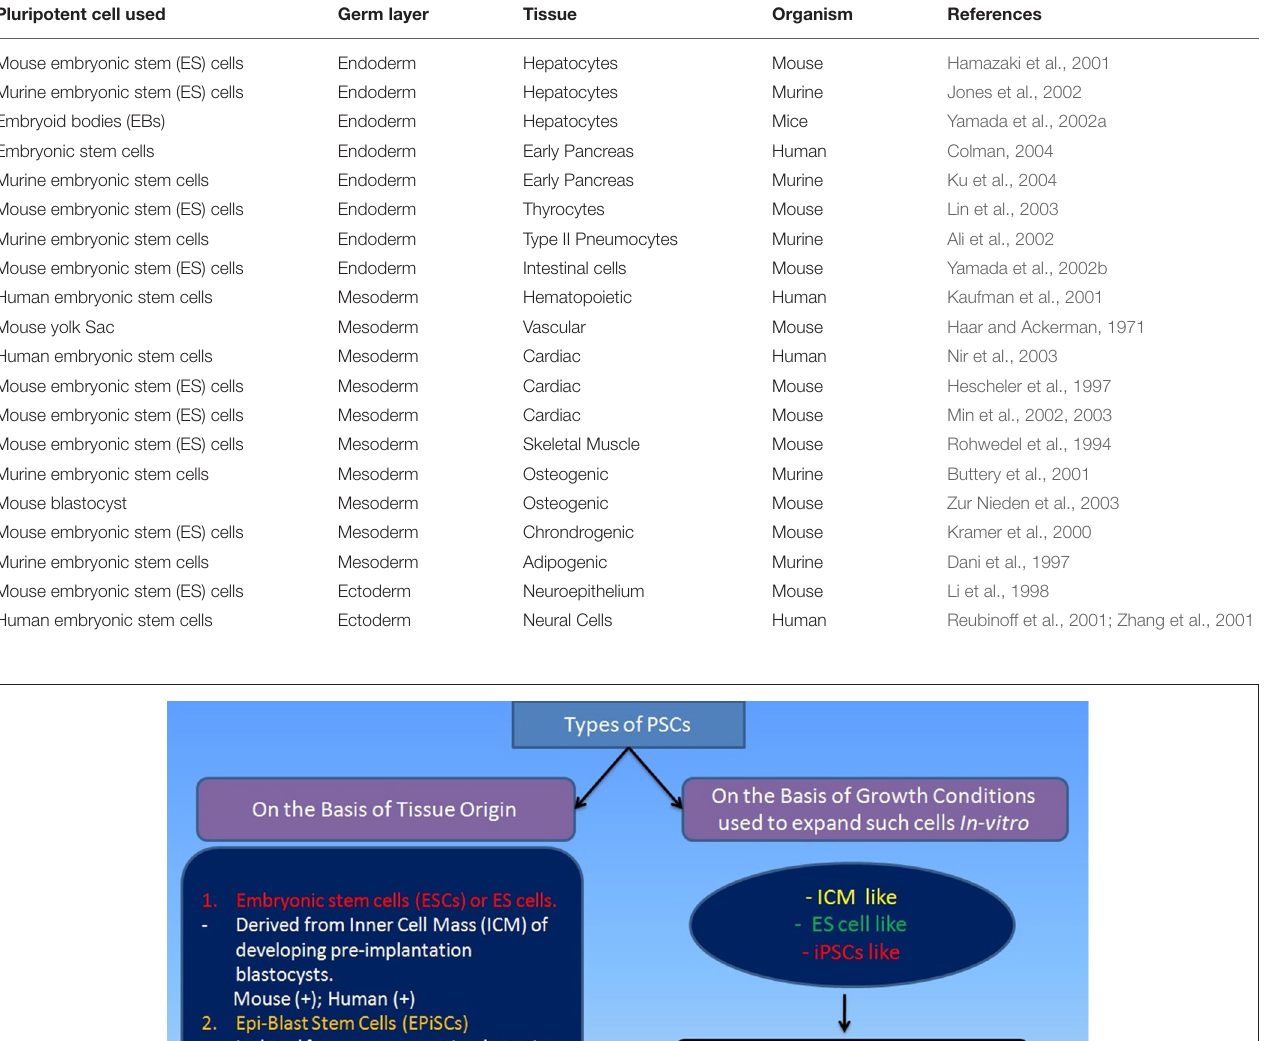
TABLE 1 | Differentiation of PSCs in all the three cell lineage.